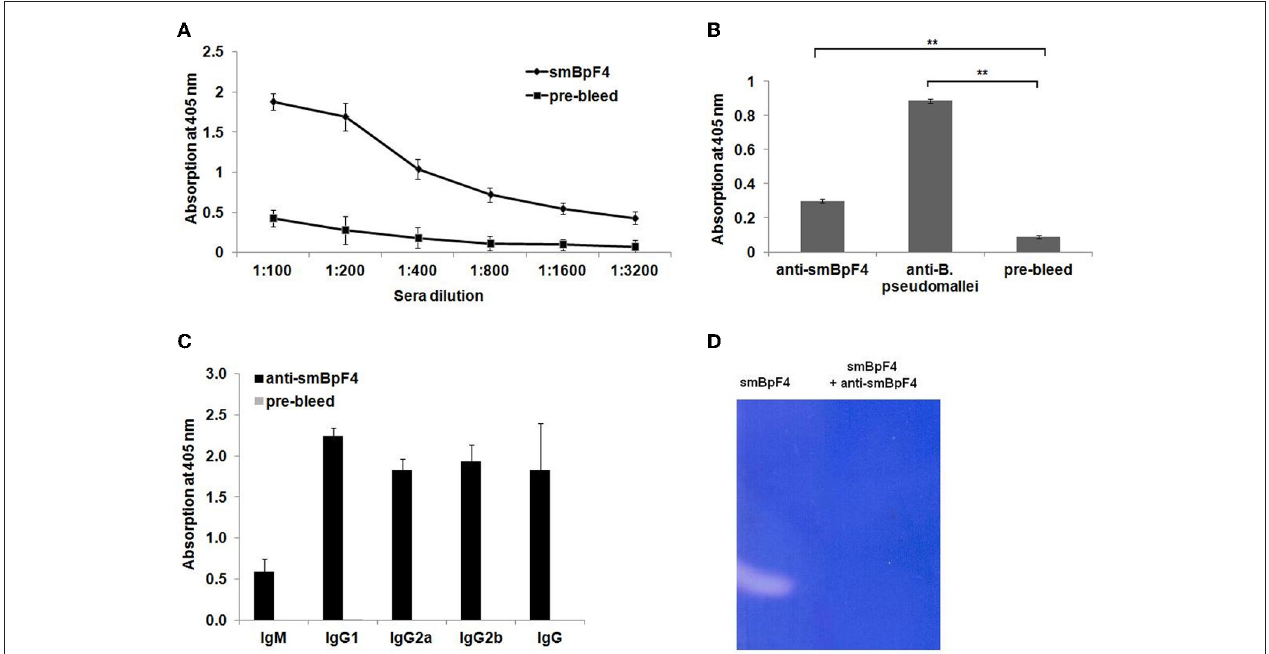
FIGURE 3 | Recombinant MprA protein is immunogenic and induces a strong antibody response. (A) Screening of smBpF4-specific IgG (anti-smBpF4) in immunized BALB/c mice. Mice ( n = 4) were immunized with 100 μ g of purified recombinant smBpF4. Sera collected prior to and after immunization were pooled and levels of anti-smBpF4 were analyzed by ELISA. The presence of specific antibodies to purified smBpF4 protein (black circles) was observed in sera from immunized mice but not in pre-immunized